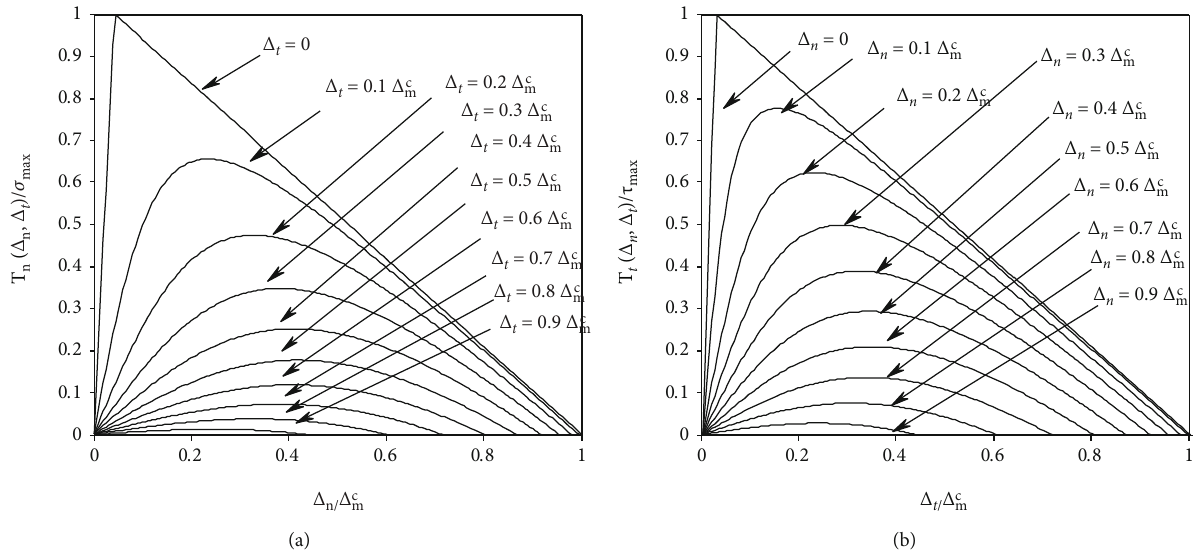
Figure 21: (a) Normal traction in bilinear CZM in ABAQUS with respect to the increase of the tangential separation; (b) tangential traction in bilinear CZM in ABAQUS with respect to the increase of the normal separation.